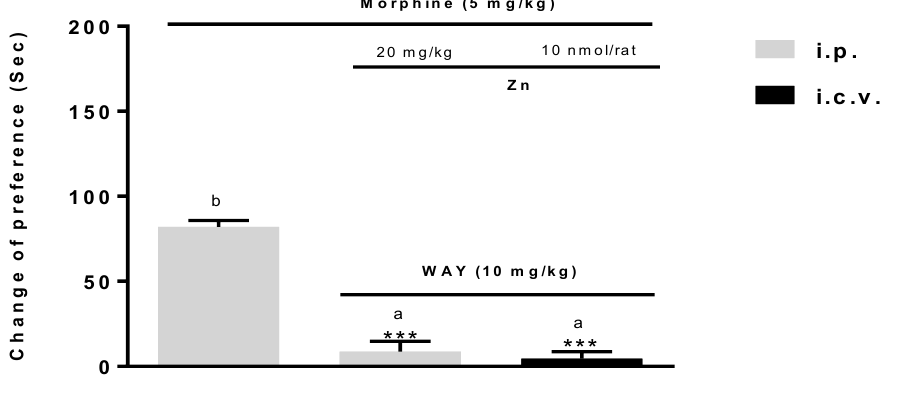
Figure 7. Effect of WAY100135 on the enhancement effect of Zn on the expression of morphine-induced CPP. Zn was given i.p. (20 mg/kg) and i.c.v. (10 nmol/rat) separately after the WAY100135 treatment in the post-conditioning sections. Each point represents the mean± SEM of six rats. *** Presents significant between saline (10 ml/kg, i.p.) group at p < 0.001. Different letters indicate significant differences between groups (p<0.05) (Tukey’s post-hoc test). Zn=Zinc, and WAY= WAY100135.